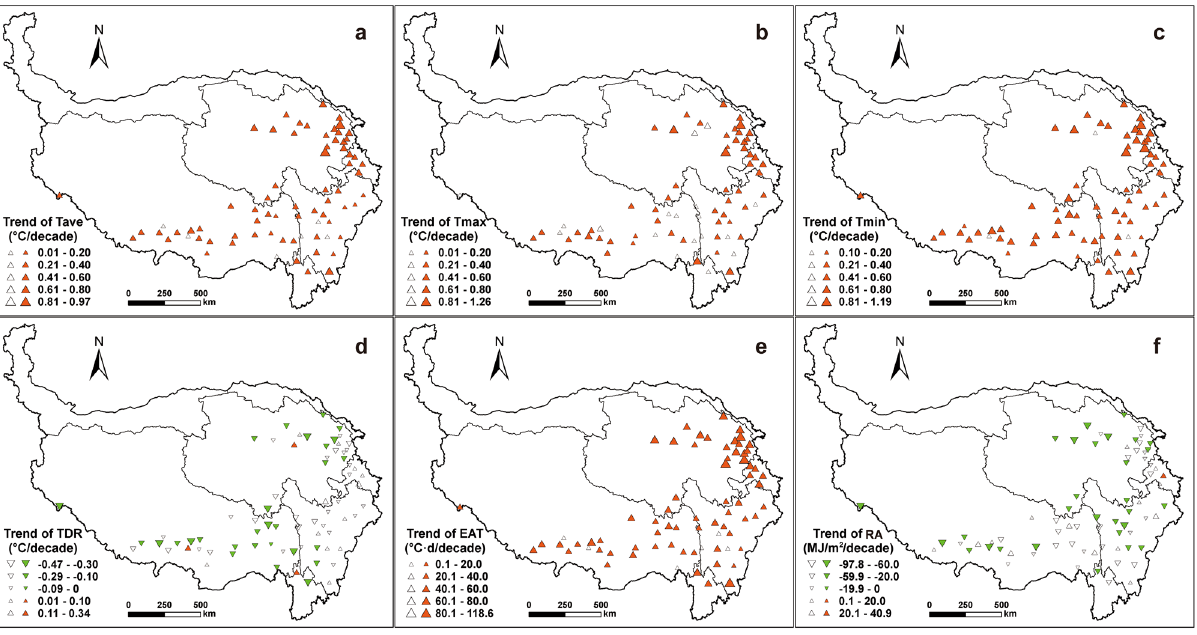
Figure 5. Change trends of Tave ( a ), Tmax ( b ), Tmin ( c ), TDR ( d ), EAT ( e ) and RA ( f ) in the growing season at 72 stations in the Qinghai-Tibet Plateau from 1978 to 2017. Red and green triangles indicate significantly upward and downward trends ( p < 0.05), and the hollow triangle indicates insignificant trends. The size of triangle is proportional to change magnitude. Maps were generated using ArcMap 10.7 software ( © ESRI, https://